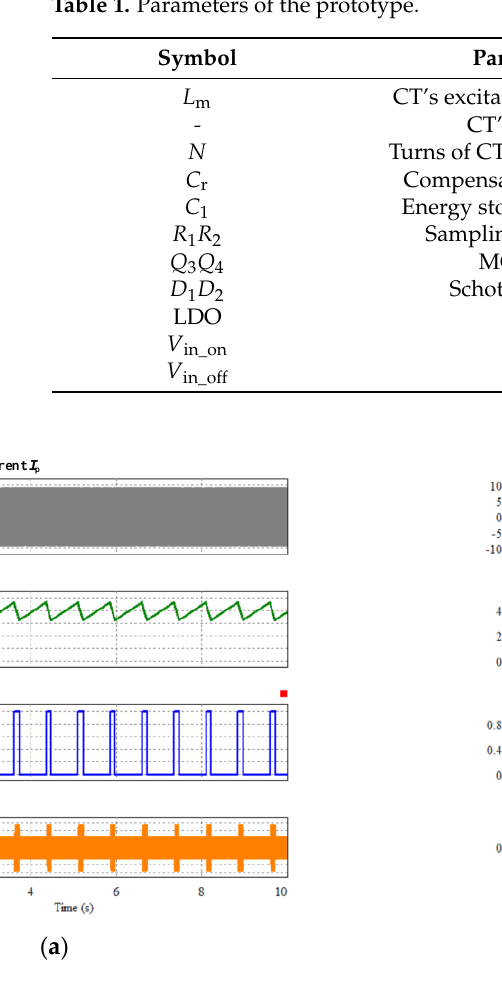
Figure 13. The simulation results of the proposed sensor. ( a ) The transmission line current is 10 A. ( b ) The transmission line current is 5 A.